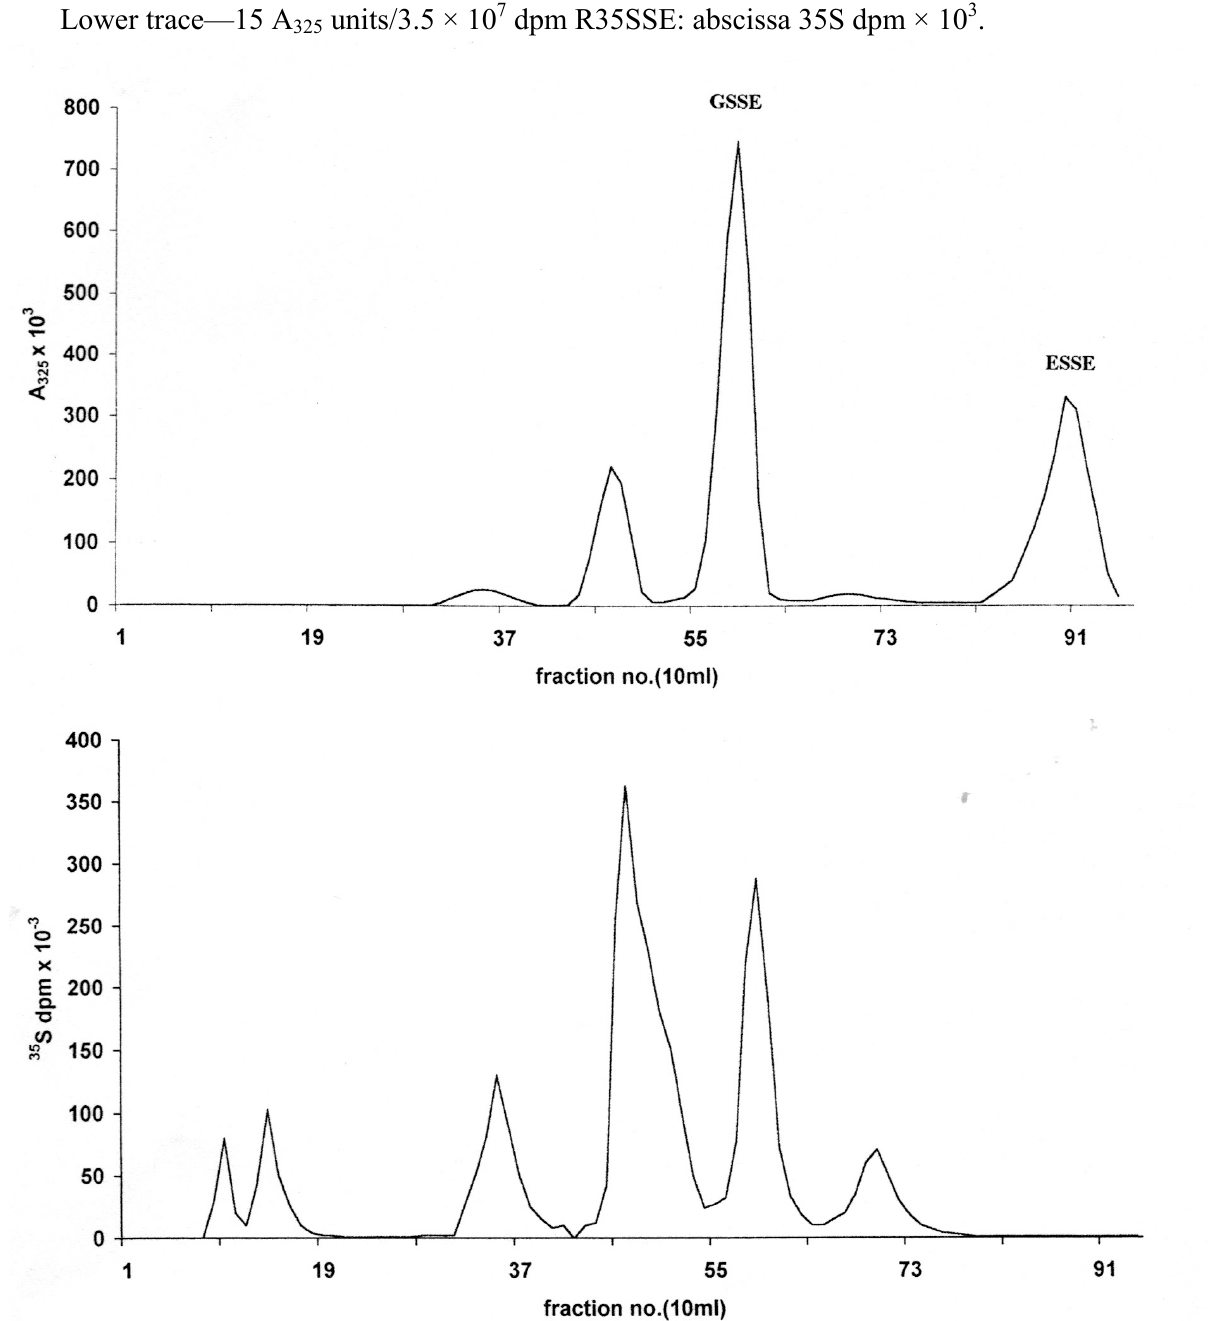
Figure 2. Anion exchange chromatography of RSSE isolated from LNCap ASF on ODS-AQ (peak 2) using a 30 × 2 cm column of DE52 cellulose. Elution consisted of a 125 mL wash with 20 mM Tris-HCl pH 7.2 containing 5% v/v methanol followed by an 800 mL linear gradient to 0.35 M guanidinium chloride 20 mM Tris-HCl pH 7.2 containing 5% v/v methanol at a flow rate of 1 mL/min. 10 mL fractions were collected. Upper trace—Applied 60 A units of RSSE: abscissa A × 10 3 ; 325 325 Lower trace—15 A units/3.5 × 10 7 dpm R35SSE: abscissa 35S dpm × 10 3 325